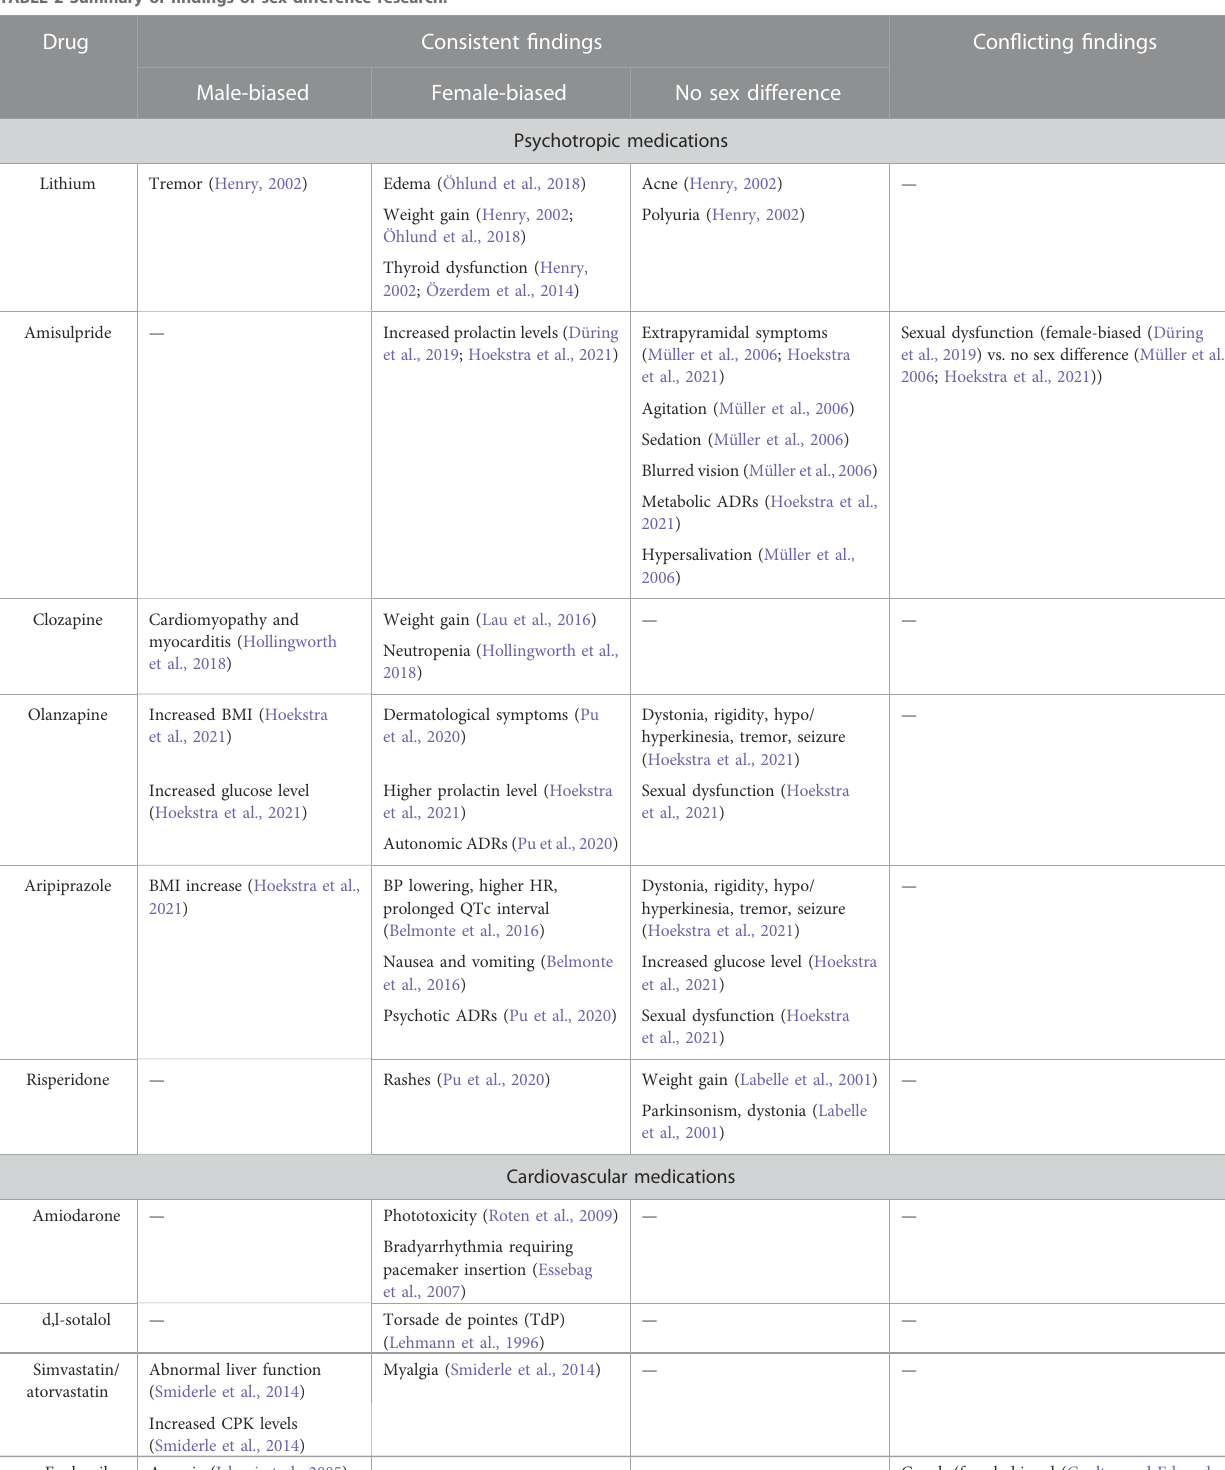
TABLE 2 Summary of fi ndings of sex difference